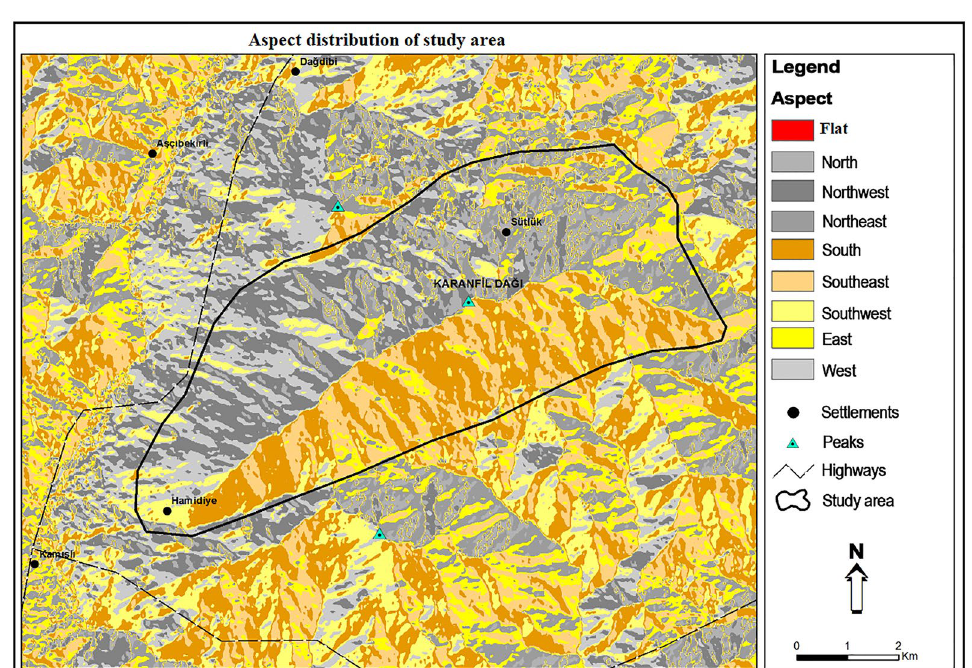
Fig. 14 Aspect distribution map of the study